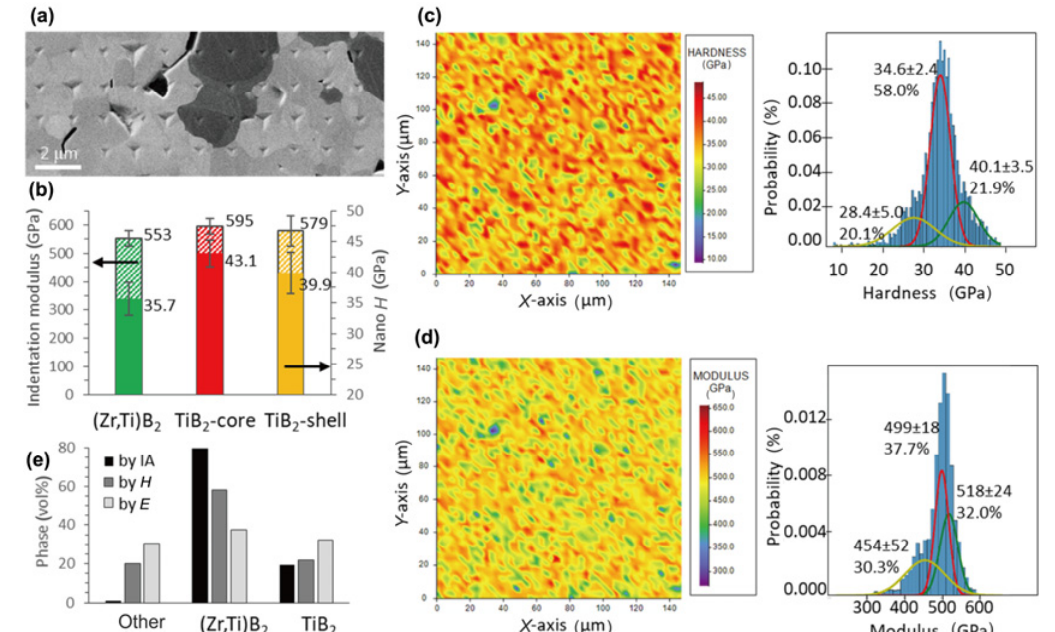
Fig. 14 (a) Portion of a nanoindentation array as viewed by SEM and (b) corresponding hardness and modulus obtained on material ZTC-B with the XP nanoindenter at 80 nm controlled penetration depth. (c) Hardness and (d) modulus maps with corresponding mechanical property histograms overlapped to the deconvolution curves determined by iMicro nanoindenter at 15 mN controlled load (values of hardness or modulus of each distinguished phase are reported on the histograms together with the calculated phase content). (e) Comparisons of the phase volume fraction obtained by image analysis (IA), nanohardness ( H ), and modulus ( E ) from (c) and